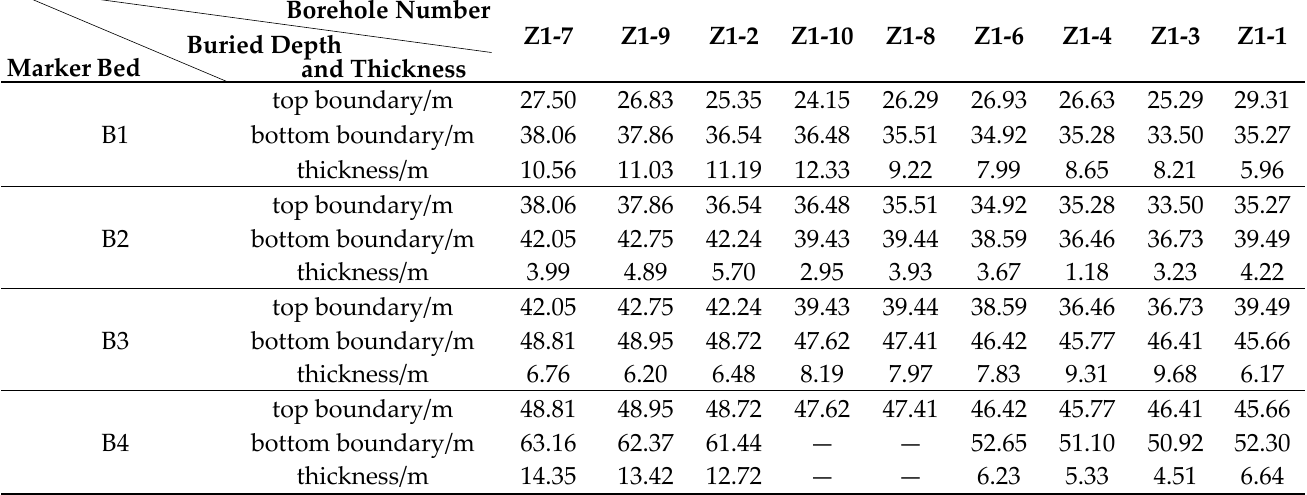
Table 2. The buried depth and thickness of marker beds revealed by composite drilling section in Xietan Village.